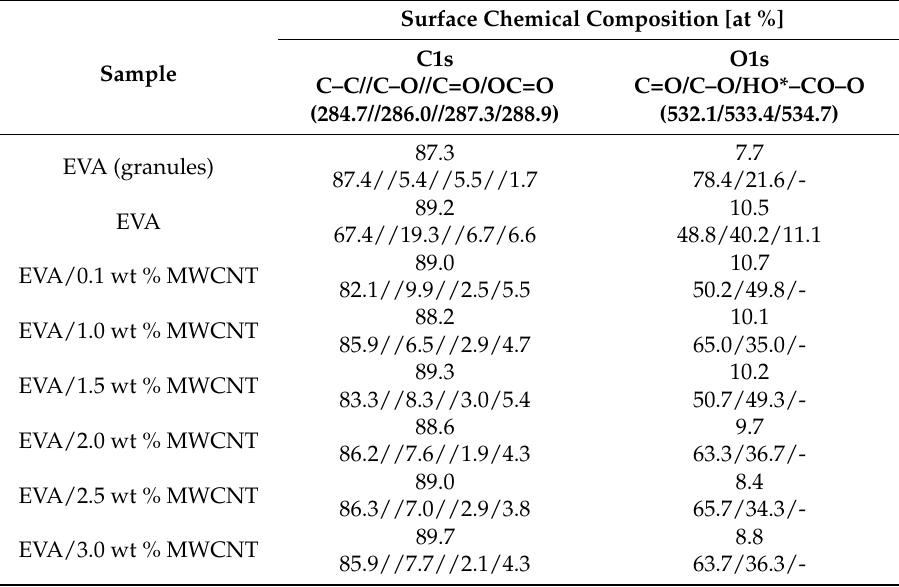
Table 2. Elemental surface composition (in at